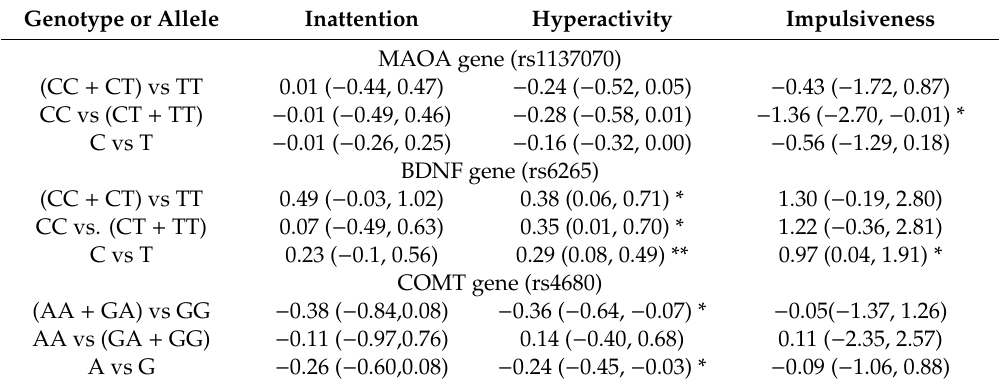
Table 2. The association between MAOA, BDNF, and COMT polymorphisms and outcome variables. Genotype or